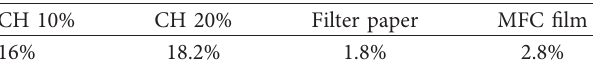
Figure 4: TEM images of the MMFC cryogel and filter paper/MFC film with MNPs (note that the filter paper was treated three times for iron coprecipitation). Table 2: MNP loading in MFC cryogels (10 and 20% chitosan (CH)), filter paper, and MFC films calculated based on residue mass (TGA, 575 ° C) per dry sample